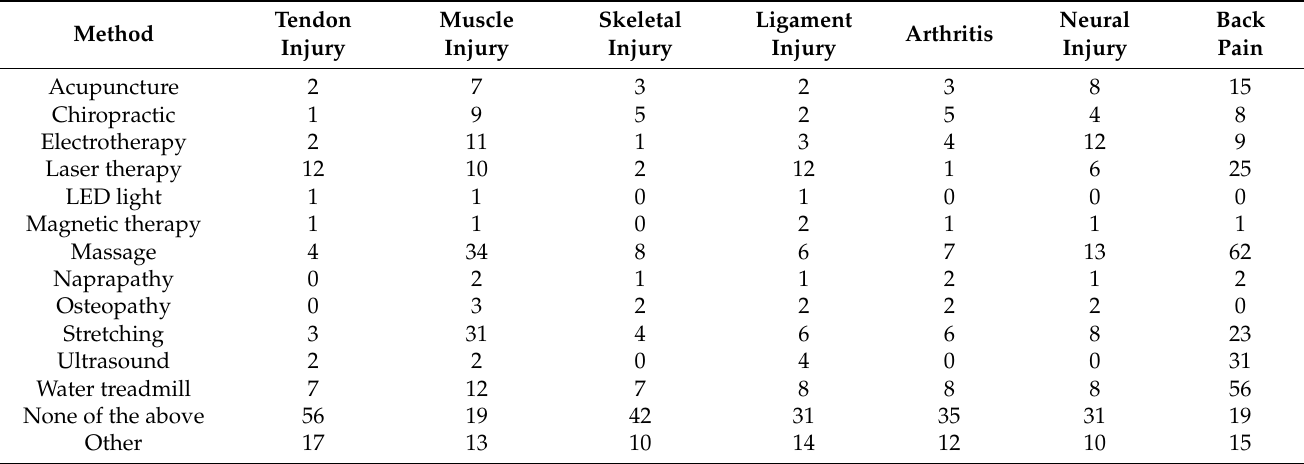
Table 3. Complementary and alternative veterinary medicine (CAVM) methods used or recommended for different indications by Swedish small animal veterinarians responding to a questionnaire. ( n = 216, multiple choices